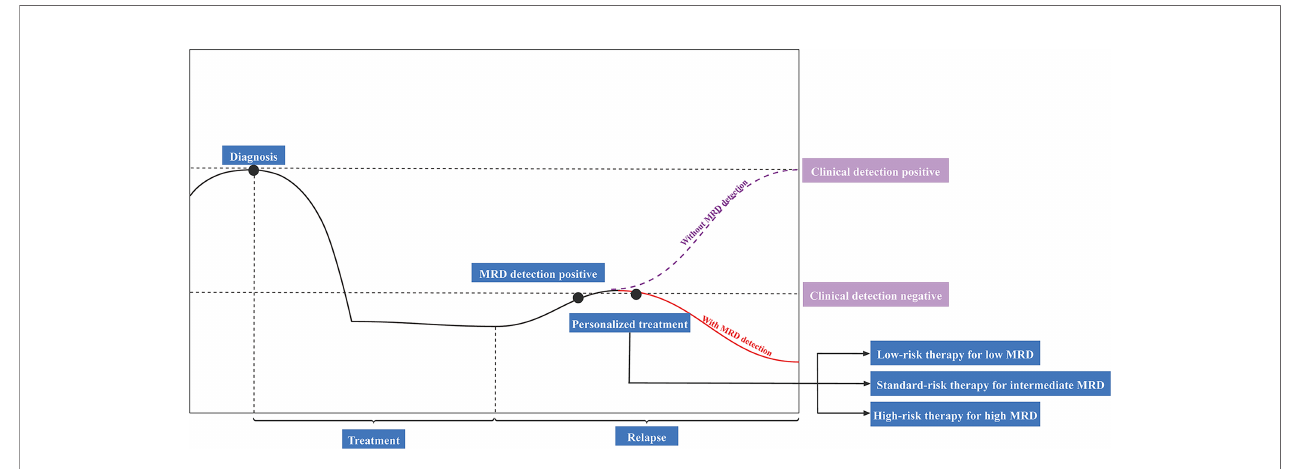
FIGURE 3 | Potential clinical applications of ctDNA-based detection for minimal residual disease (MRD). ctDNA, circulating